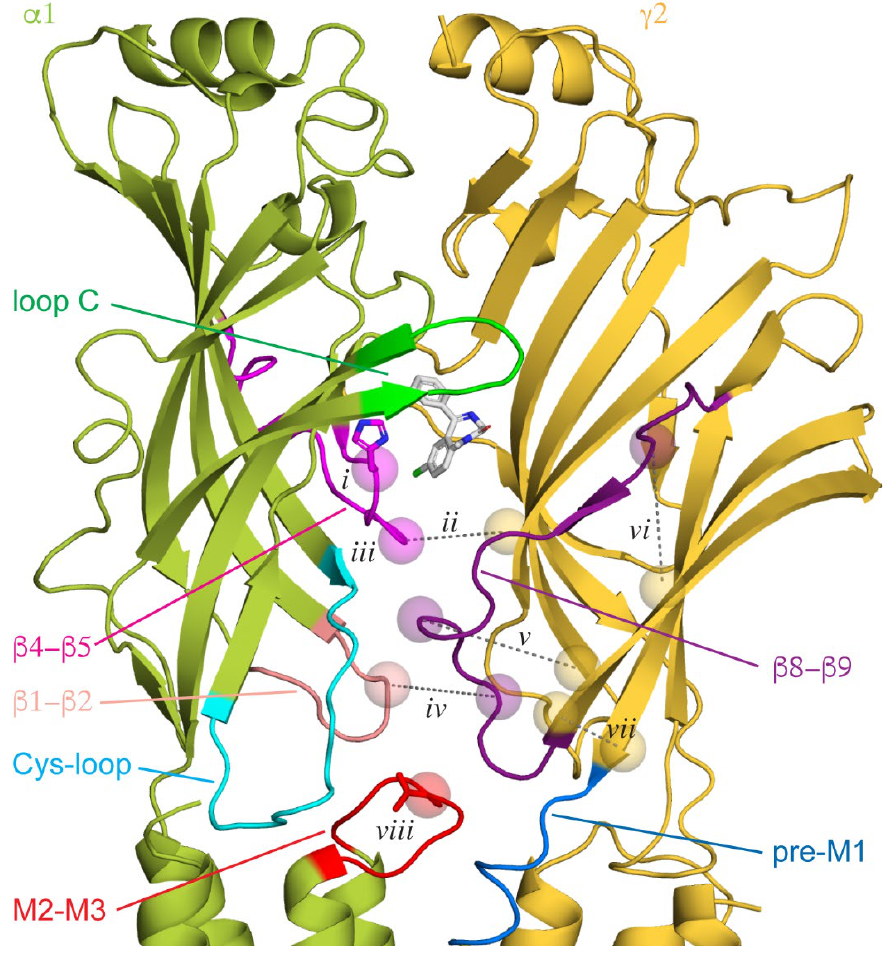
Figure 2. Canonical ECD binding α +/ γ − interface, with diazepam (DZ) shown as white sticks bound behind loop C. Other loops implicated in binding or intersubunit interactions are indicated. Cryo-EM map for GABA A ( α 1) 2 ( β 3) 2 ( γ 2) 1 from PDB 6HUP. Features discussed in the main text are indicated with spheres for residue C α atoms and dashed lines for cross-linked residue pairs (numbered labels are referenced in the main text). The critical histidine residue in the β 4− β 5 loop within the BZD binding pocket ( i ) and the central valine residue in the α 1 M2-M3 linker ( viii ) are shown as sticks.